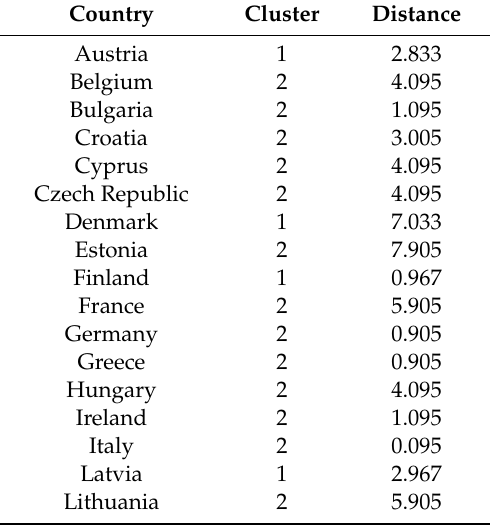
Table 9. Groups of countries considering the targets for the share of RESs in the consumption of energy (K-means